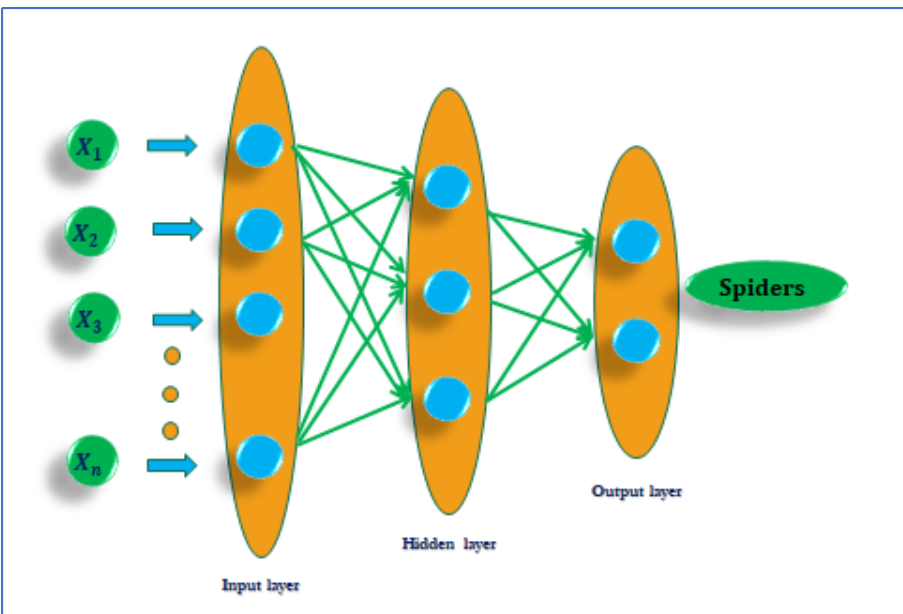
Figure 2. A multilayer perceptron (MLP) architecture with one hidden layer.